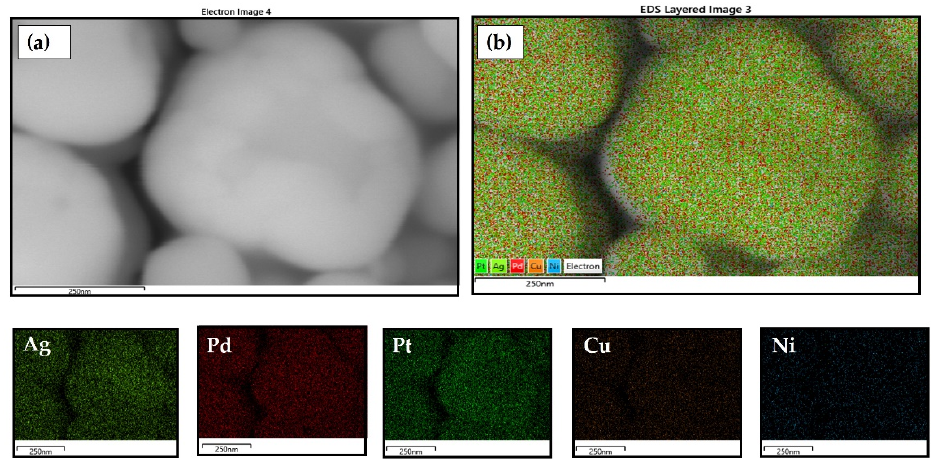
Figure 9. CCNPs: ( a ) SEM micrograph, ( b ) Elemental mapping of Ag, Pd, Pt, Cu, and Ni on the surface.